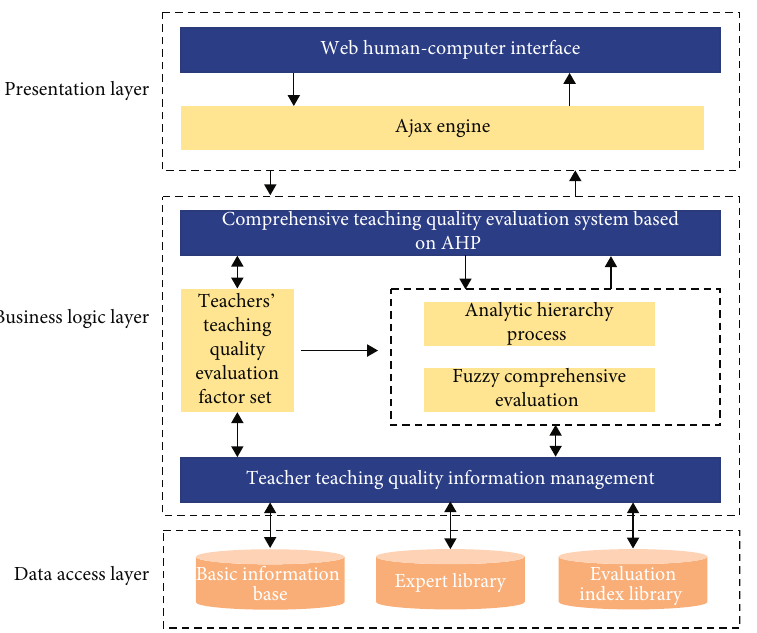
Figure 1: System architecture diagram of the comprehensive evaluation system of college mathematics teaching quality evaluation system based on AHP.